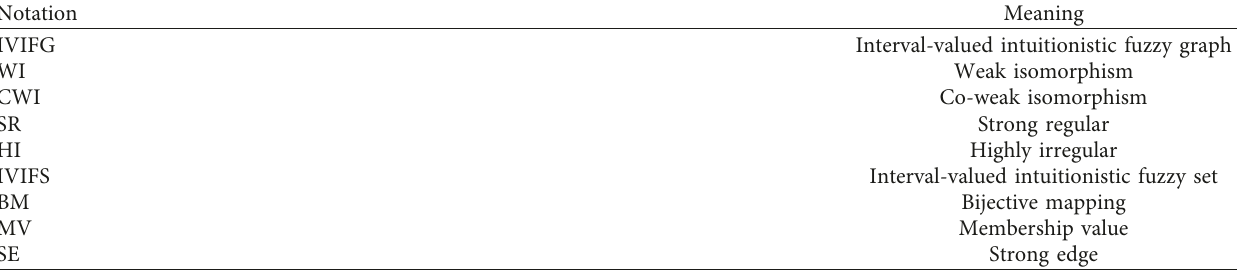
Table 1: Some basic